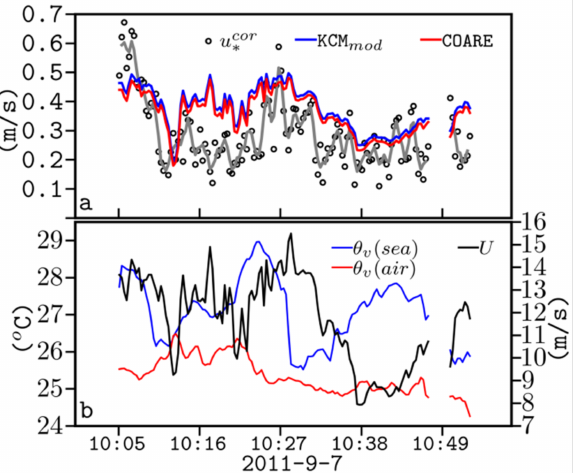
Figure 9. ( a ) As in Figure 8a and ( b ) as in Figure 8b, but for the flight segment at the southeast AS, on 9 September 2011 (as displayed in Figure